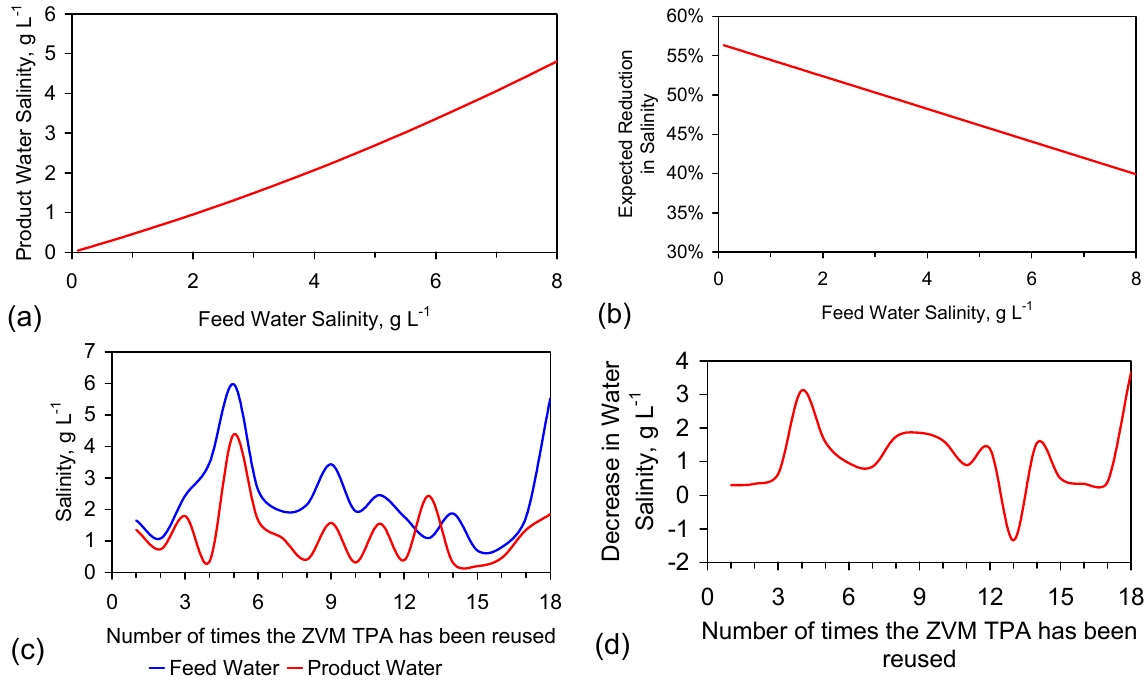
Figure 21. Partial desalination of water using ZVM TPA: E146, 0.4 kg ZVM TPA; 240 L water. ( a ) Regression relationship between feed water salinity and product water salinity; ( b ) Regression relationship between the proportion of the salinity removed and the feed water salinity; ( c ) Feed and product water salinities vs. number of times a batch of ZVM TPA is reused; ( d ) Amount of NaCl removed vs. number of times a batch of ZVM TPA is